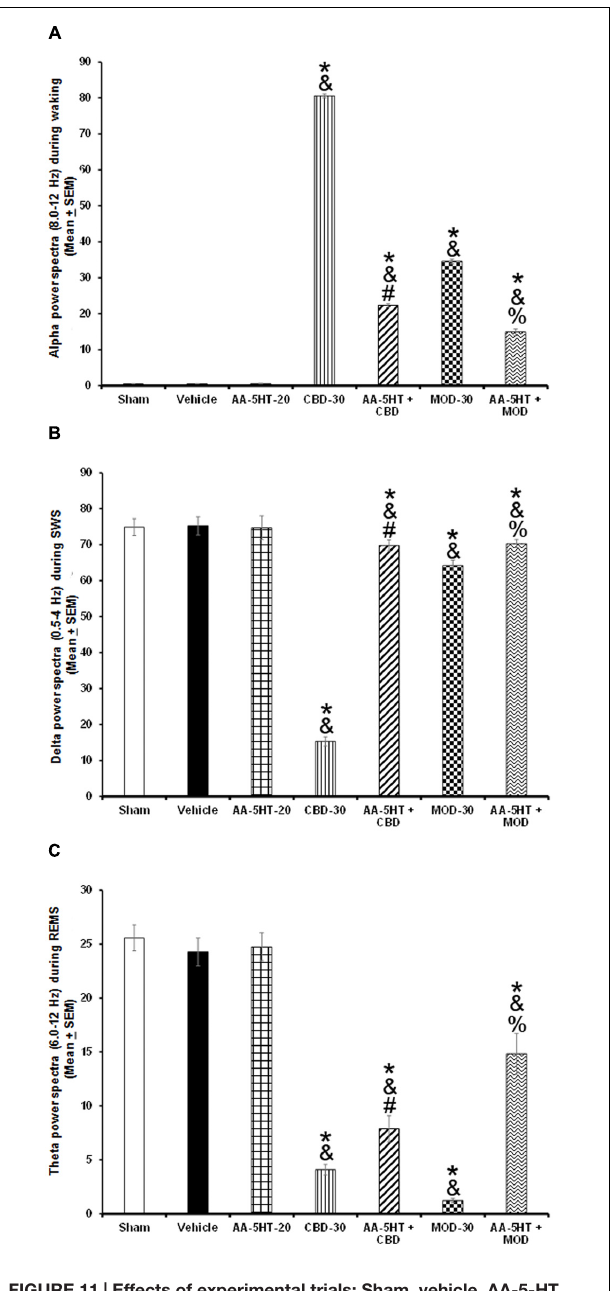
FIGURE 11 | Effects of experimental trials: Sham, vehicle, AA-5-HT (20 mg/Kg; i.p.), cannabidiol (CBD; 30 mg/Kg; i.p.), AA-5-HT (20 mg/Kg; i.p.) and 15 min later CBD (30 mg/Kg; i.p.), modafinil (MOD; 30 mg/Kg; i.p.) or AA-5-HT (20 mg/Kg; i.p.) and 15 min later MOD (30 mg/Kg; i.p.) during the sleep rebound period in sleep-deprived rats on power spectra alpha (for W: α = 8–12 Hz), delta (for SWS: (cid:49) = 0.5–4.0 Hz) or theta power spectra (for REMS: (cid:50) = 6.0–12.0 Hz). AA-5-HT caused no effects in power spectra. However, CBD or MOD partially increased alpha and decreased delta and theta power spectra. Importantly, the administration of AA-5-HT before injection of either CBD of MOD prevented the increase in alpha as well as blocked the diminution in delta and theta ( A–C , respectively. Mean ± SEM ∗ vs. Sham/Vehicle, P < 0.05; & vs. AA-5-HT-20, P < 0.05; # vs. CBD-30, P < 0.05; % vs. MOD-30, P < 0.05). Abbreviations: Cannabidiol 30 mg/Kg, i.p. (CBD-30), modafinil 30 mg/Kg, i.p.